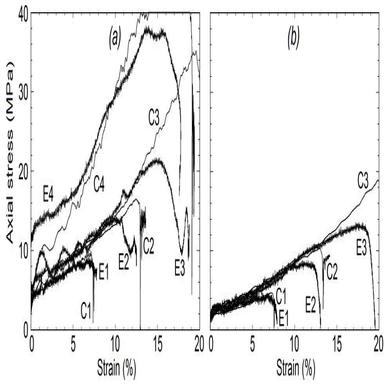
The calculated stress-strain response with fitted compaction kinetic compared with the experiments for the coarse silica sand: as received and pre-compacted (4), ρ0 = 1.415(1), 1.41(2), 1.4(3), 1.53(4) g/cm3 (a) and moisturised, ρ0 = 1.41(1), 1.425(2), 1.415(3) g/cm3 (b).